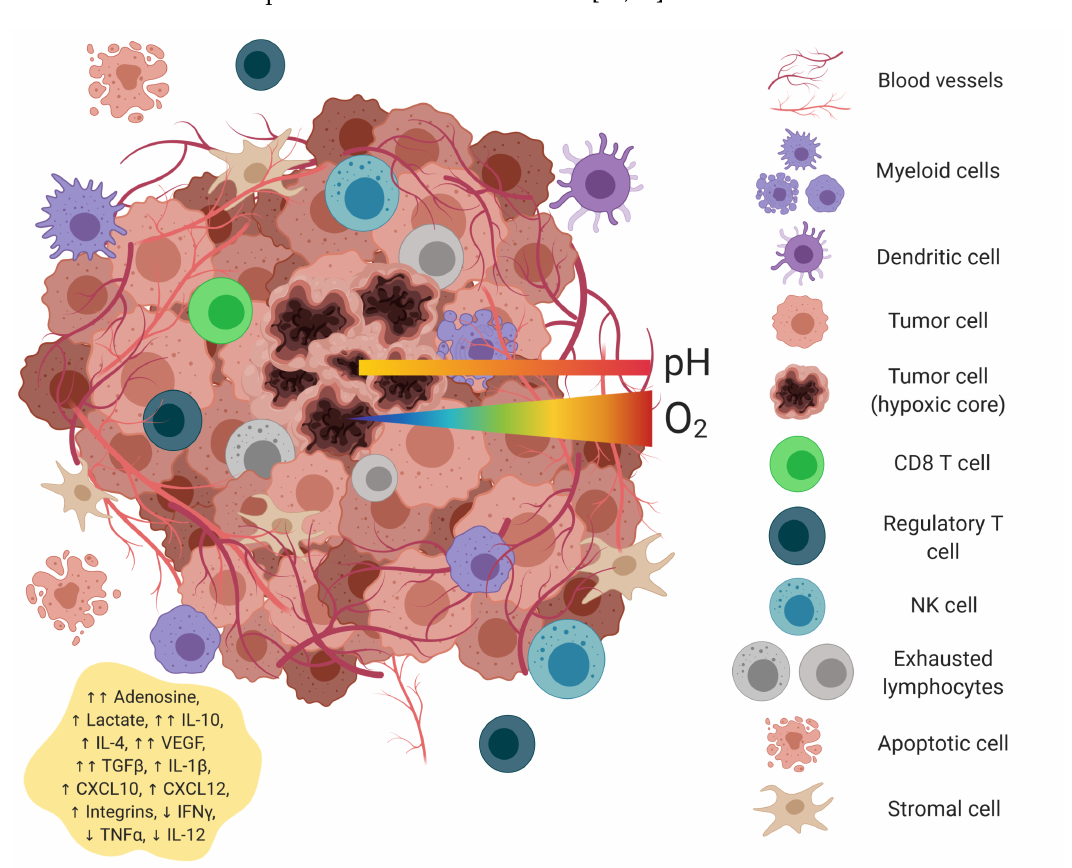
Figure 2. Components of the tumor microenvironment. The tumor microenvironment is a complex ecosystem of heterogeneous tumor cells, stromal cells, and a variety of immune cells residing in a network of dysregulated vasculature and collagen. Poor perfusion and densely-packed glycolytic tumor cells create pockets of diminished oxygen levels, acidic pH, poor nutrient loads, anti-inflammatory cytokines, chemokines, and accumulated metabolic by-products, such as lactate. Tumor-infiltrating immune cells of both the myeloid and lymphoid lineages are found within the TME. Figure created with